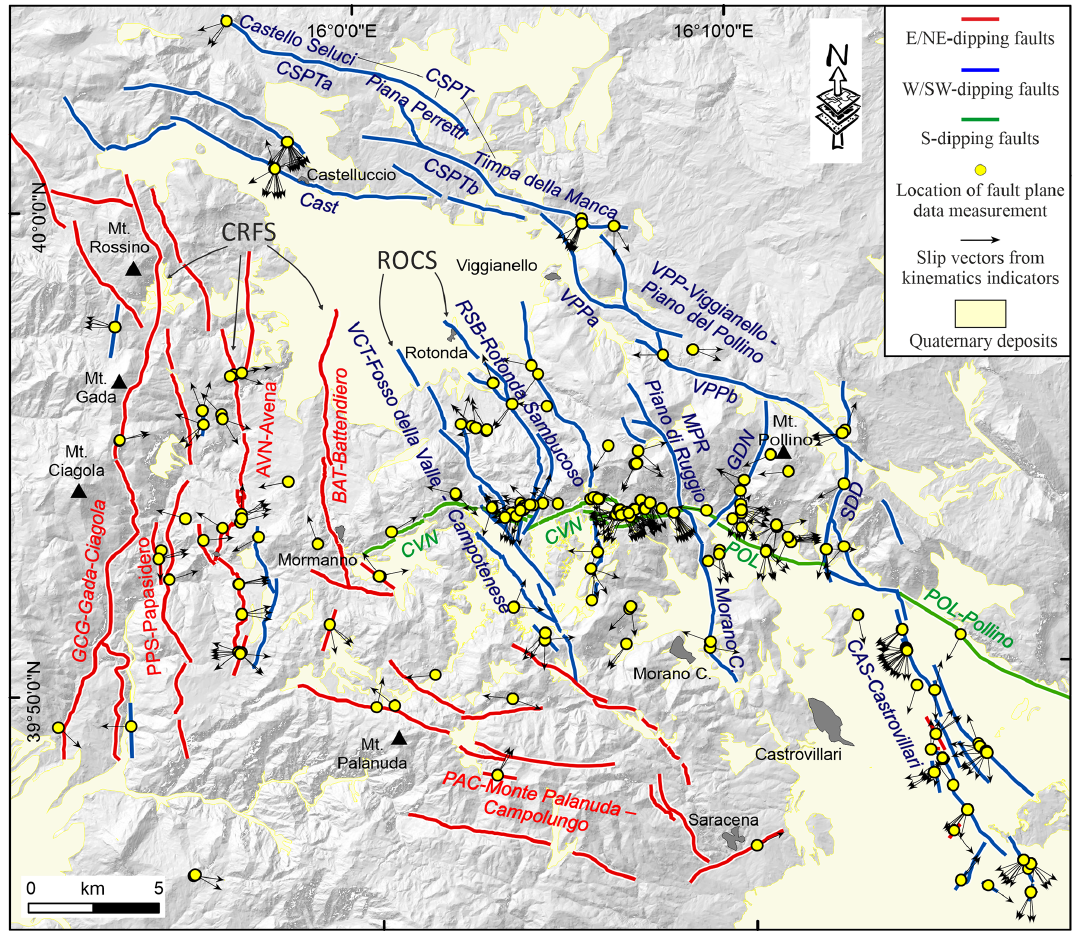
Figure 2. Structural map of the Calabrian–Lucanian boundary (after Brozzetti et al., 2017a) with location of fault-slip data